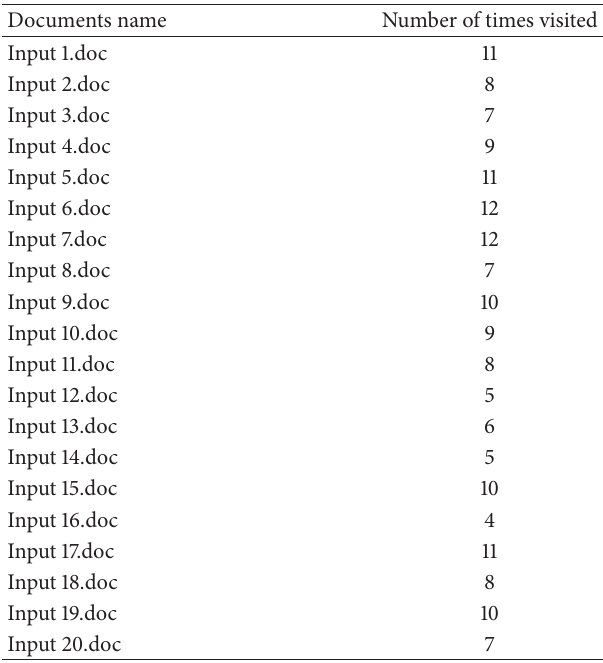
Table 1: Input documents and number of times visited.